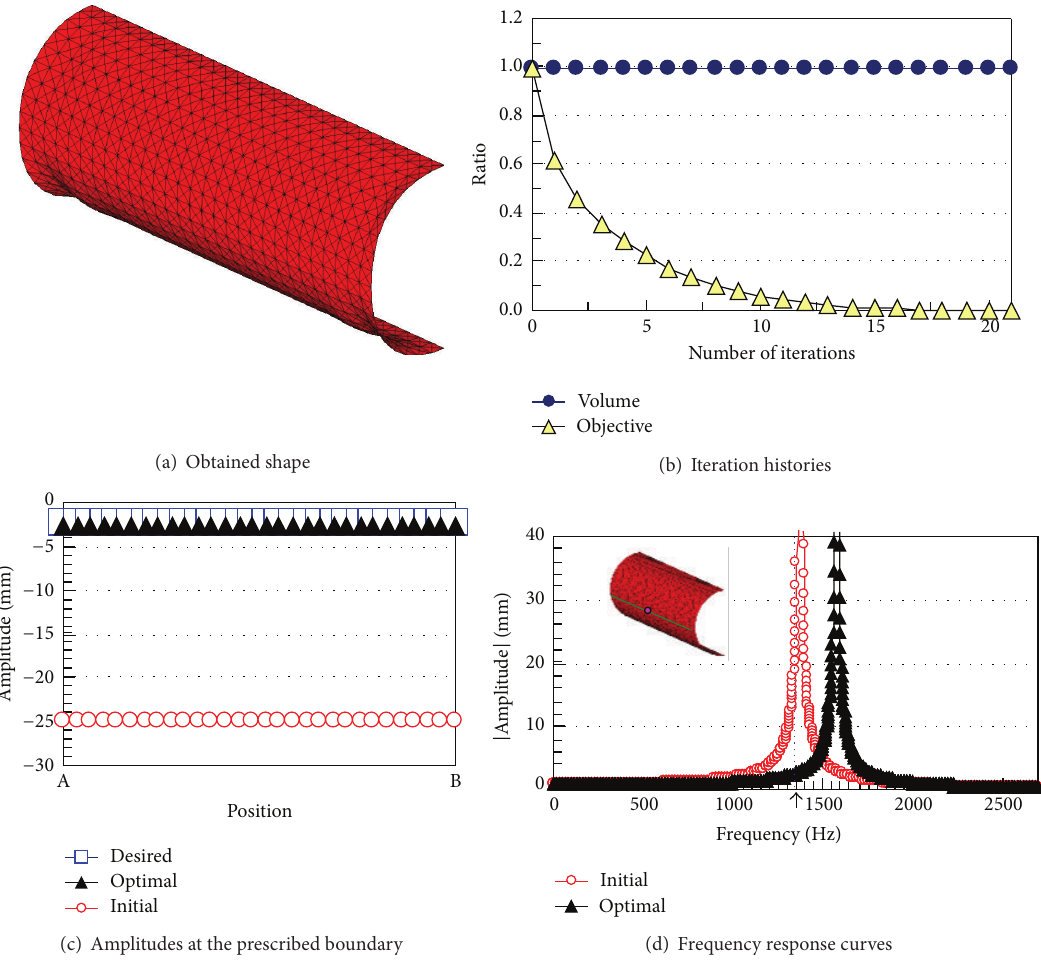
Figure 6: Optimization results of half-cylindrical shell model at 1350 Hz.